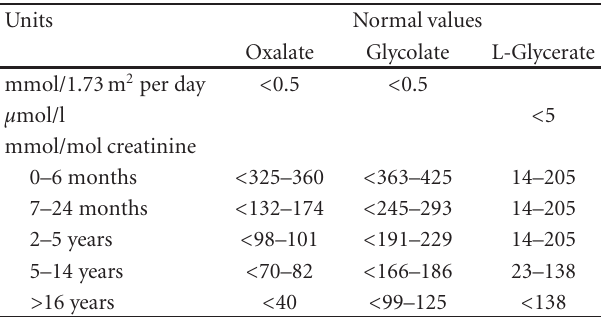
Table 1: Reference age-related values for urinary oxalate, glycolate, and L-glycerate excretion (adapted from